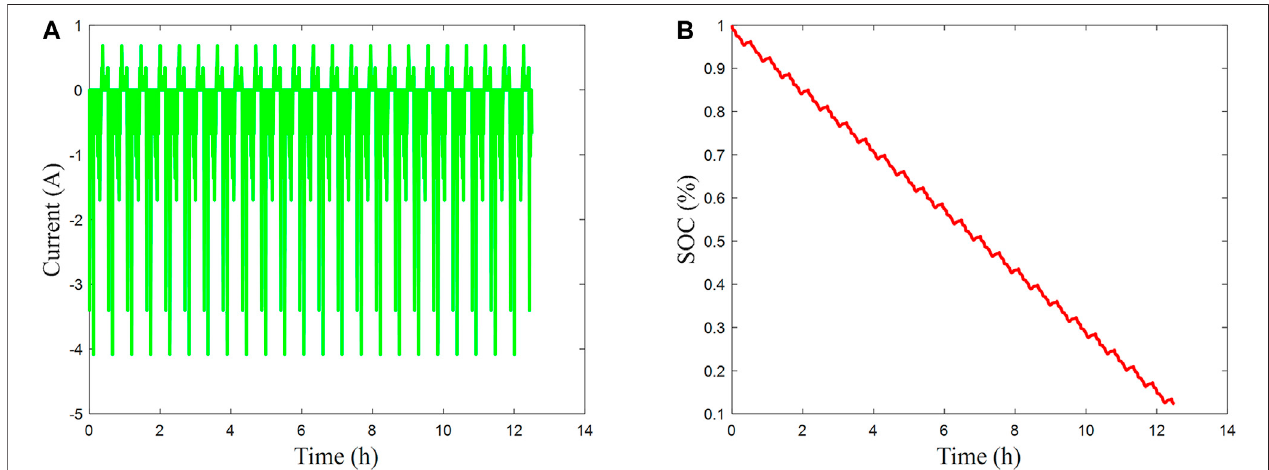
FIGURE 9 | Current and SOC curves of dynamic experiment. (A) Current curve and (B) SOC curve.